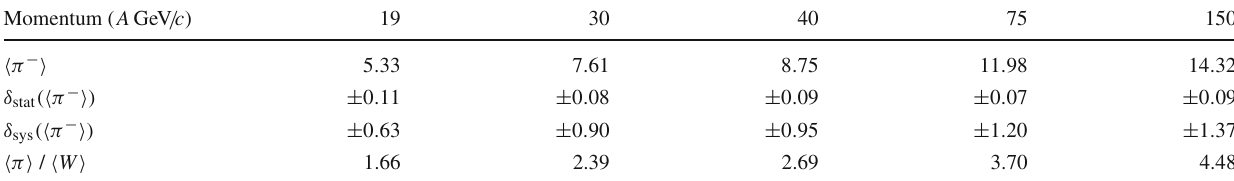
Table 5 Mean π − multiplicities in the 5% most central Be + Be collisions with statistical and systematic uncertainties as well as ratios of mean π multiplicities to average number of wounded nucleons Momentum ( A GeV / c